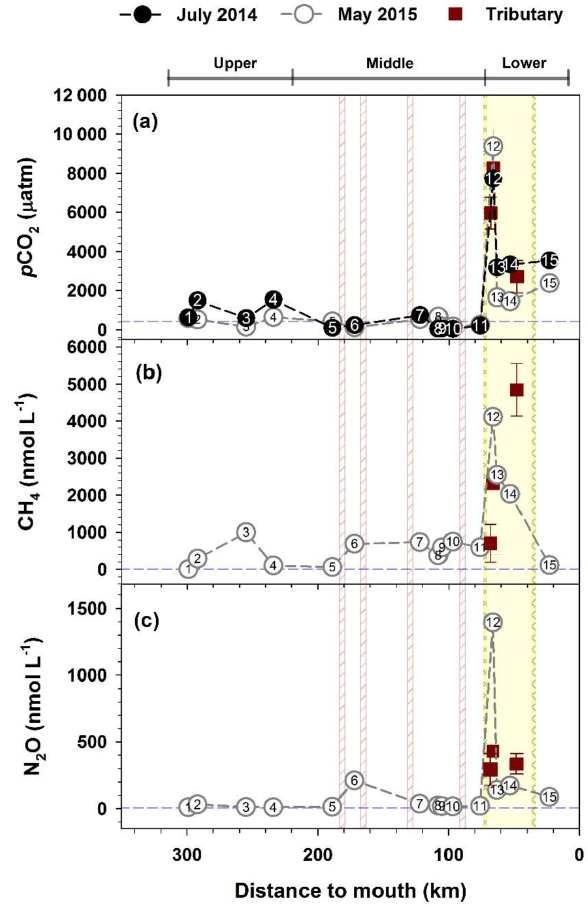
Figure 2. Spatial variations in p CO 2 (a) , CH 4 (b) , and N 2 O (c) measured at 15 sites and 3 urban tributaries along the Han River. p CO 2 was measured in two basin-wide surveys – July 2014 and May 2015 (May 2015 data are modified from Yoon et al., 2017), but CH 4 and N 2 O were measured only in May 2015. Additional measurements at the urban tributary JN (HR12; n = 13) and two other tributaries, TC ( n = 4) and AN ( n = 2) are indicated by brown squares with standard deviations. Dashed horizontal lines denote the mean value of atmospheric equilibrium for p CO 2 (435µatm), CH 4 (3.3nmolL − 1 ) , and N 2 O (6.5nmolL − 1 ) . Four vertical lines on the middle reach indicate the location of dams. The yellow shade demarcated by two spiral lines indicate the lower-reach section sep- arated by two submerged